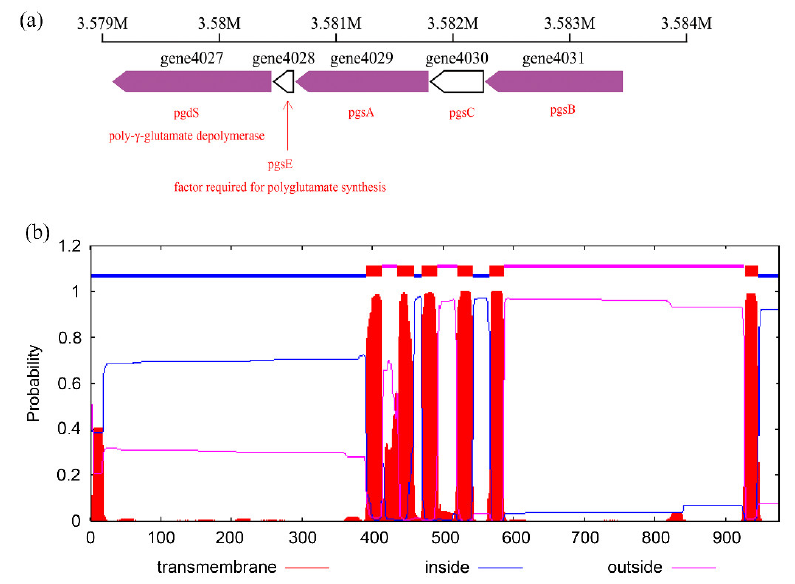
Figure 9. Map of the γ-PGA synthetase gene cluster ( pgsBCAE ) and the endo-type γ-PGA hydrolase gene ( pgdS ) in B. subtilis A-5 ( a ); analysis of the transmembrane structure of the γ-PGA synthase cluster by TMHMM ( b